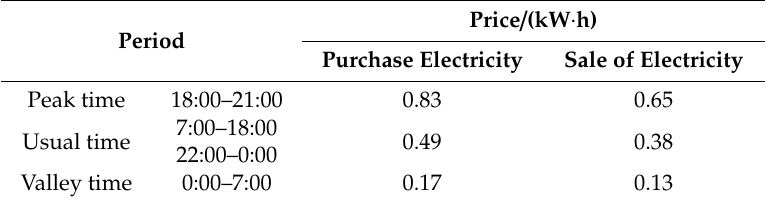
Table 1. Time-sharing electrovalence.